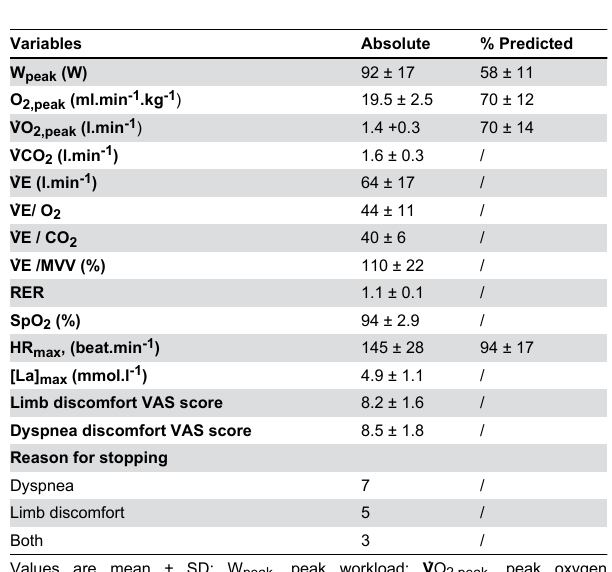
Table 3. Physiologic response at exhaustion during the constant-load cycling